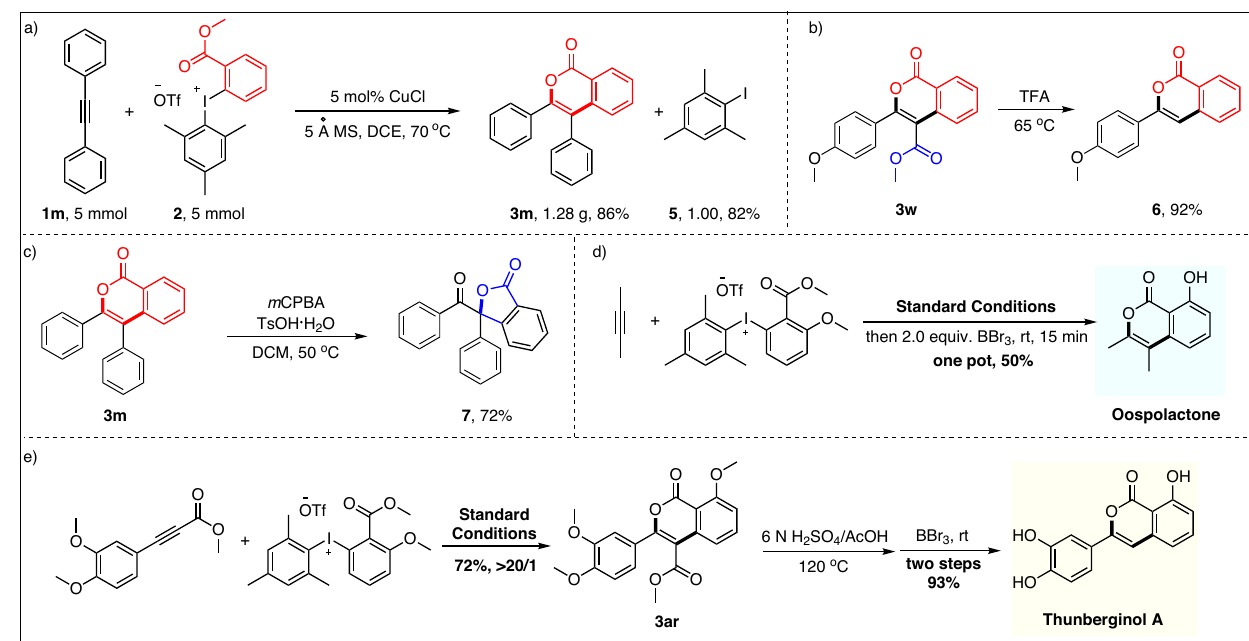
Fig. 4 Synthetic applications. a The scale-up reaction. b , c Diverse transformations of the isocoumarin products. d Total synthesis of Oospolactone. e Total synthesis of Thunberginol 5 Å MS (20 mg) were added to a dried vial sequentially. The reaction mixture was stirred at 70 °C in anhydrous DCE (0.05 M) until complete consumption of the alkyne was observed by TLC. Then it was concentrated and puri fi ed on silica gel to get the target product 3 ( Z / E selectivity was determined by crude NMR.) Full experimental details and compound characterizations are given in the Supple- mentary Information and Supplementary Data 1.